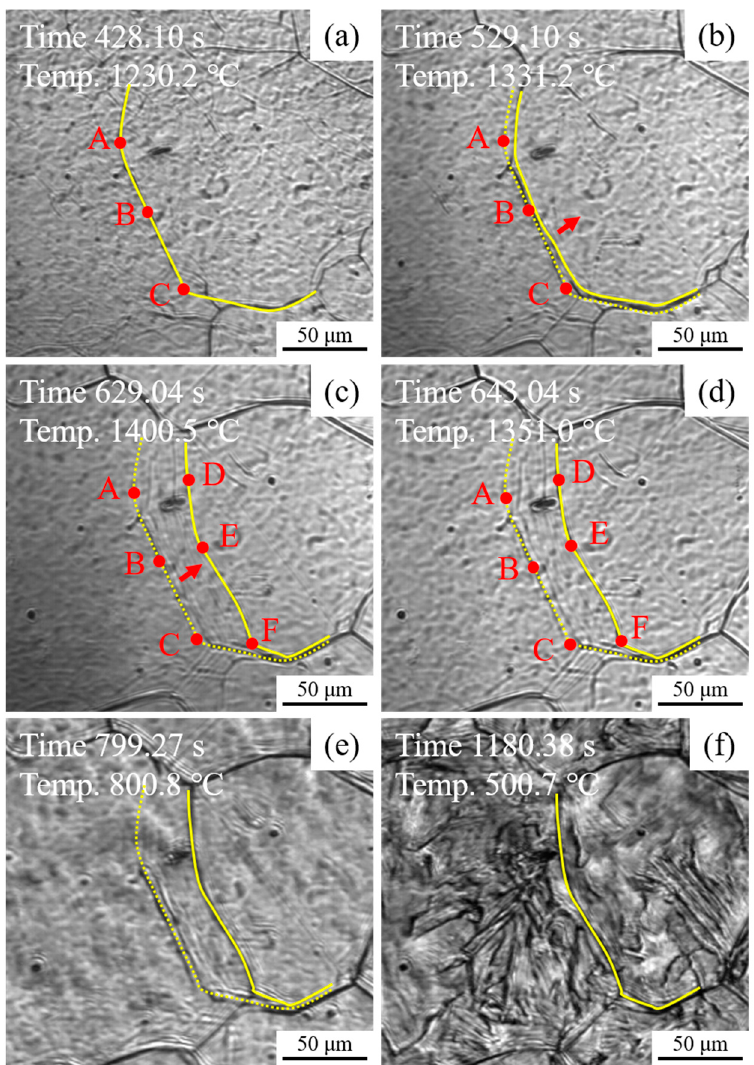
Figure 12. In situ observation of migration of austenite grain boundary during the heating and cooling process of experimental steel HM: ( a ) austenite grain boundary, ( b ) migration start, (c) migration finish, and ( d – f ) cooling process.